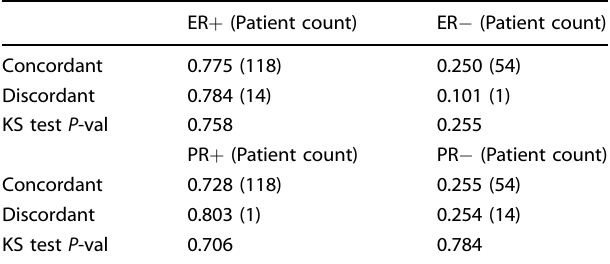
Table 3. Comparison of average image-classi fi er con fi dence for ER/PR status tasks given concordant (ER + /PR + or ER − /PR − ) or discordant (ER + /PR − or ER − /PR + ) patients.